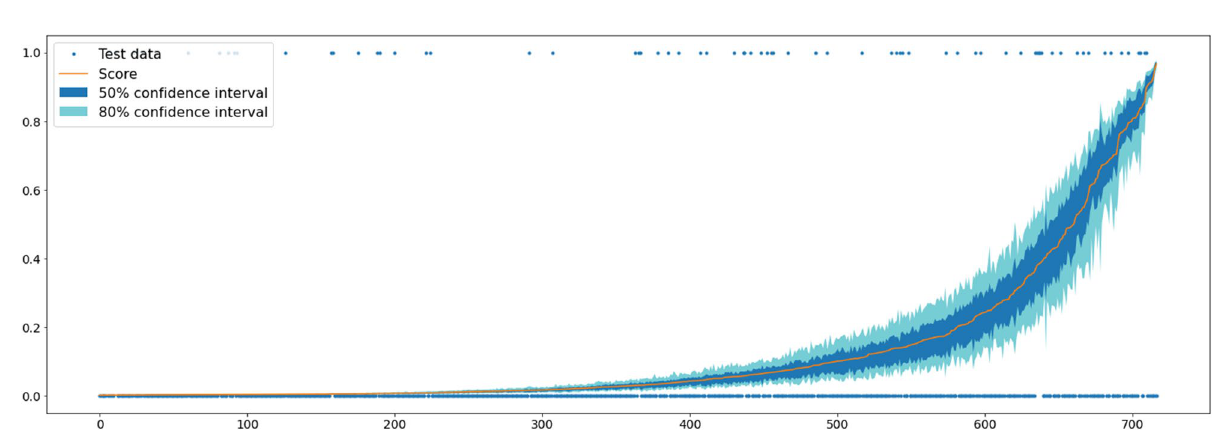
Figure 5. The predicted necrosis probabilities with the corresponding 50% (between the 25th and 50th percentiles) and 80% confidence (between the 10th and 90th